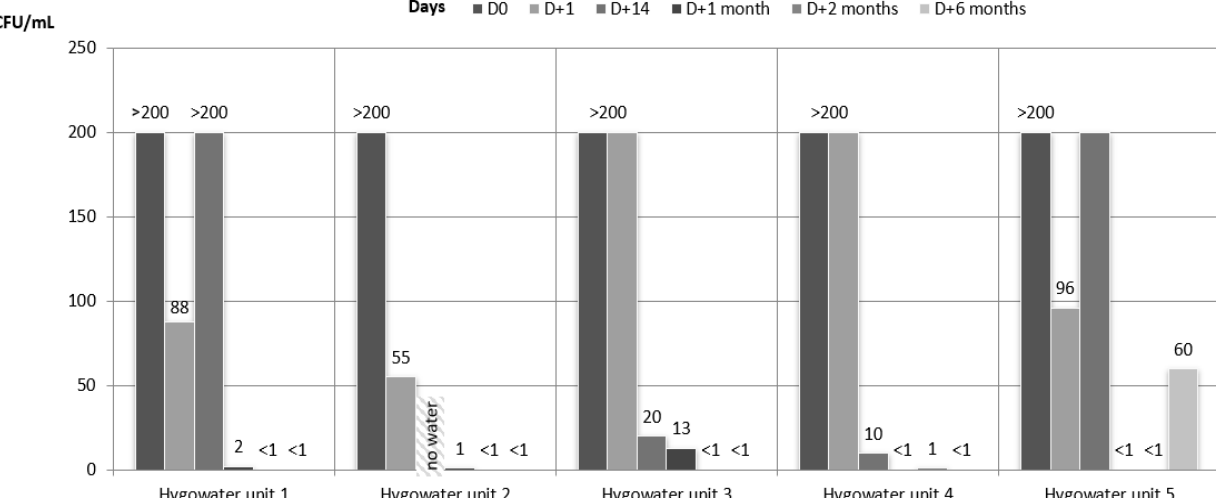
Figure 4. Microbiological quality of the water samples for the units connected to the IGN Calbenium ® system. HPC at 37°C. Figure 5. Microbiological quality of the water samples for the units connected to the IGN Calbenium ® system. HPC at 22°C.